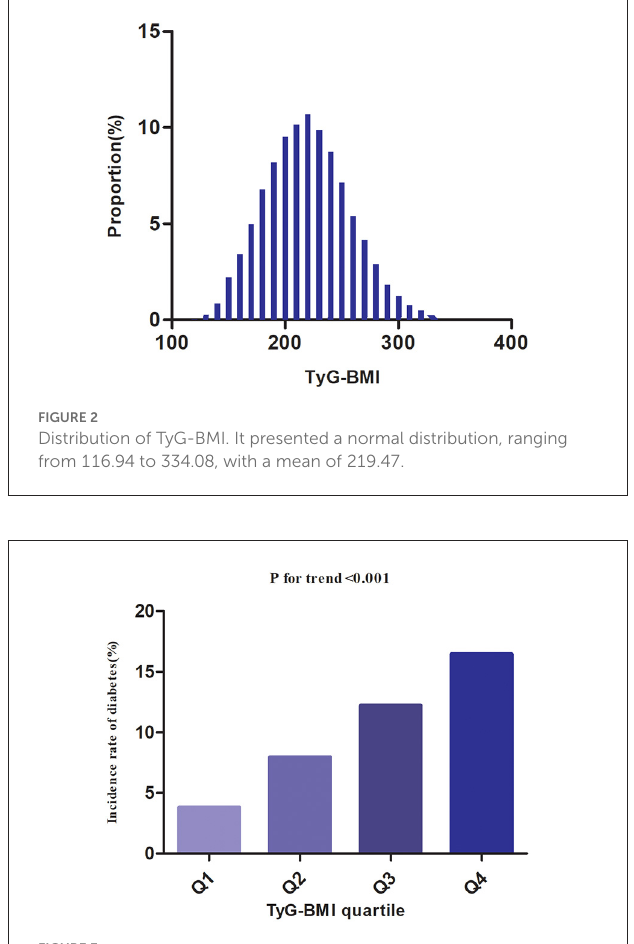
FIGURE3 The incidence rate for diabetes according to the quartiles of TyG-BMI. Participants with the highest TyG-BMI(Q4) had higher diabetes incidence rates than those with the lowest TyG-BMI(Q1) ( p < 0.001 for trend).